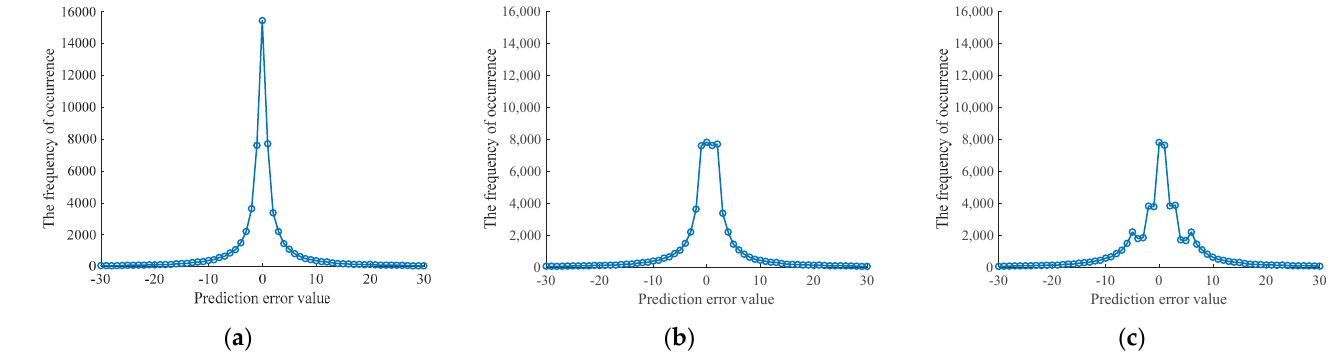
Figure 1. Histograms shifting: ( a ) Before embedding; ( b ) After embedding with expandable errors; and ( c ) After embedding with expandable errors [ − 2,2].